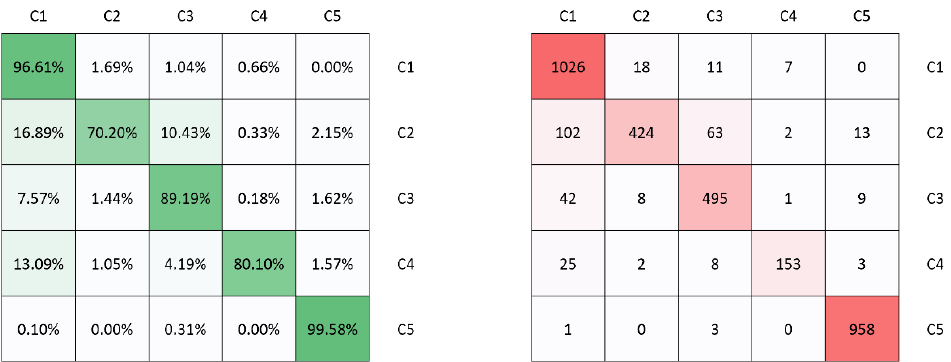
Figure 16. Confusion matrix for the best ResNet version 2 (47 layers) model. Confusion matrix of